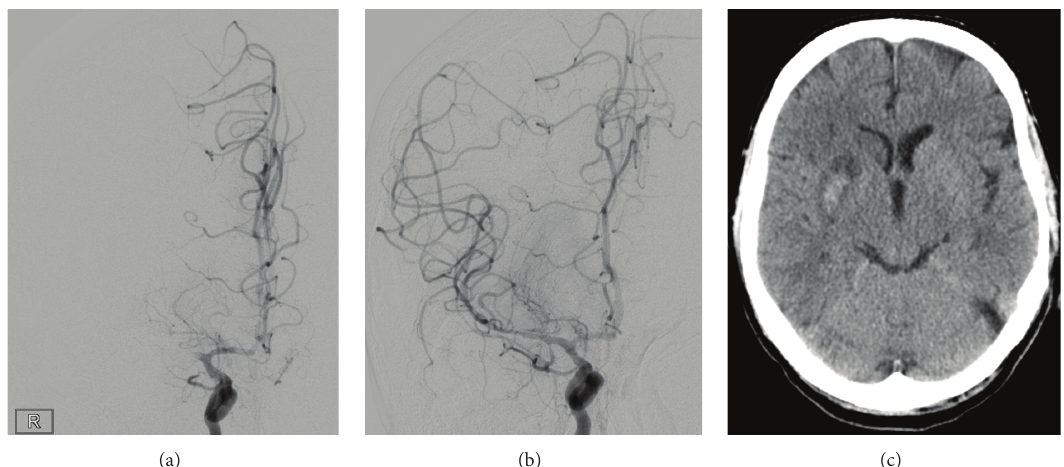
Figure 1: (a) Occlusion of middle cerebral artery TICI 0; (b) DSA following mechanical recanalization TICI 3; (c) unenhanced CCT on day 2 (24 hours) with a slight hemorrhagic infarction HI1.